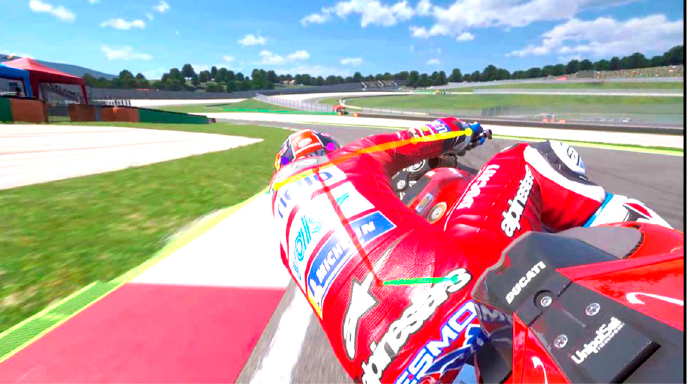
Figure 7. Errors in the OpenPose processing of the MotoGP19 frame regarding rear camera 2.